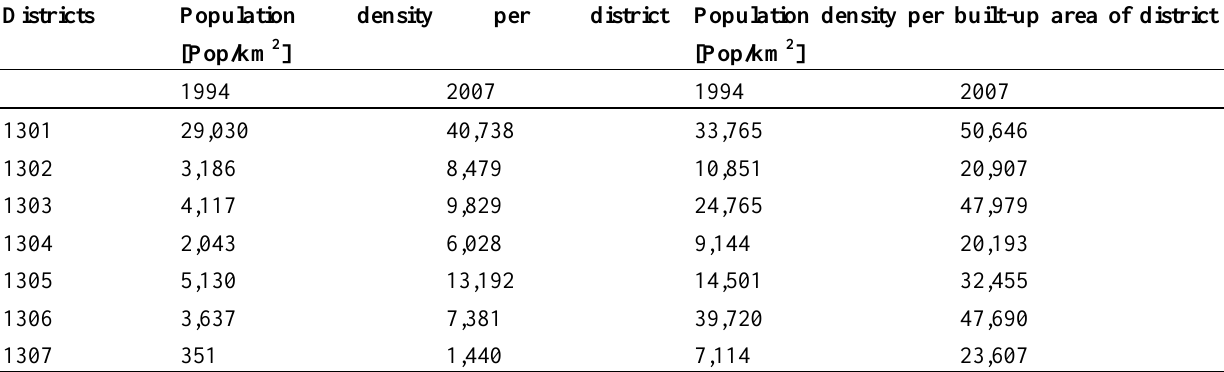
Table 6. Population density per district and population density per built-up area of each district for the years 1994 and 2007.